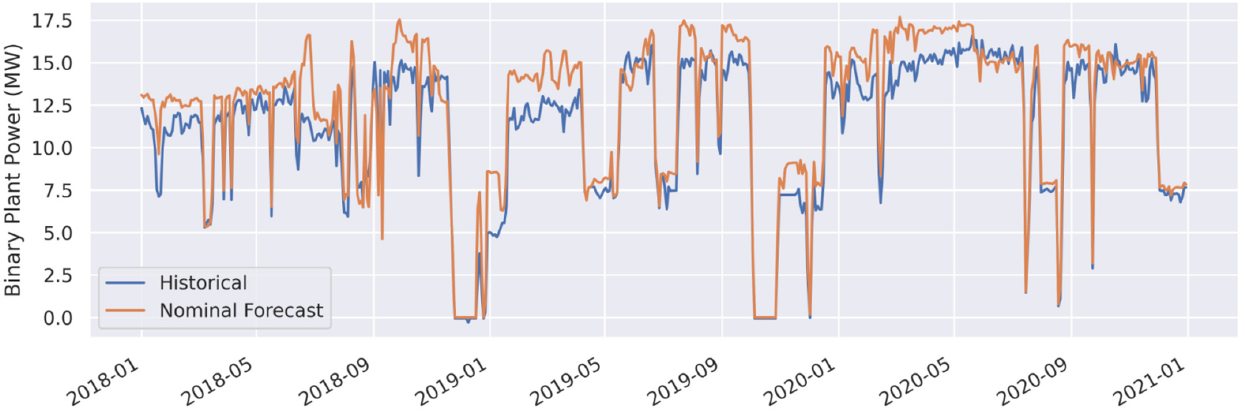
Energies 2021 , 14 , 6852 14 of 20